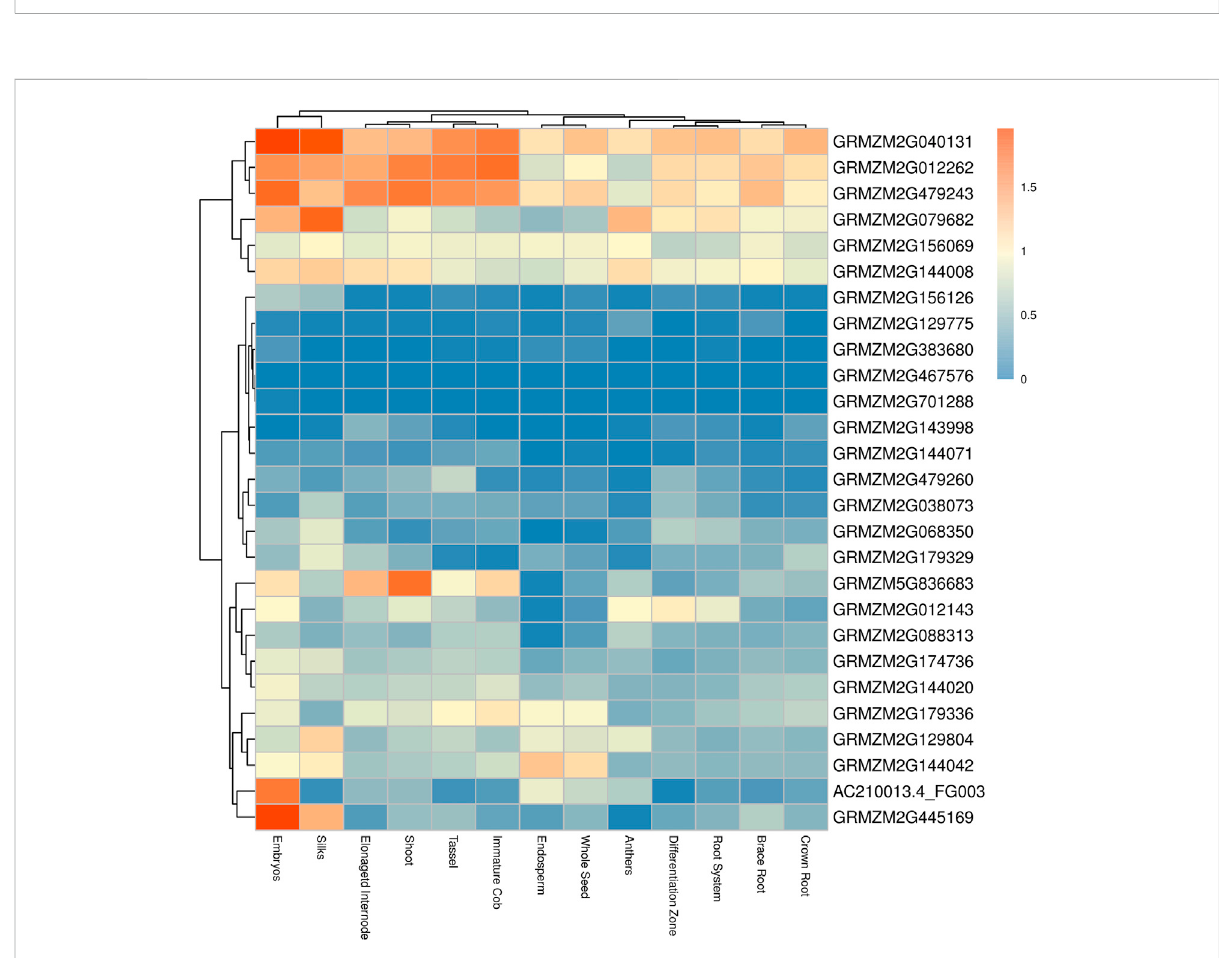
FIGURE 8 Expression patternsof candidate genes identi fi ed by MLM. Each expressionin the graph is the log 10 (n + 1)transformed value of TPM counts for bracerootandothertissues,asindicatedatthebottomofeachcolumn.Rowsandcolumnsaredistributedaccordingtosimilarity(clusteranalysison top and left). Orange, white and blue represent higher, moderate and lower genes expressed in each tissue,